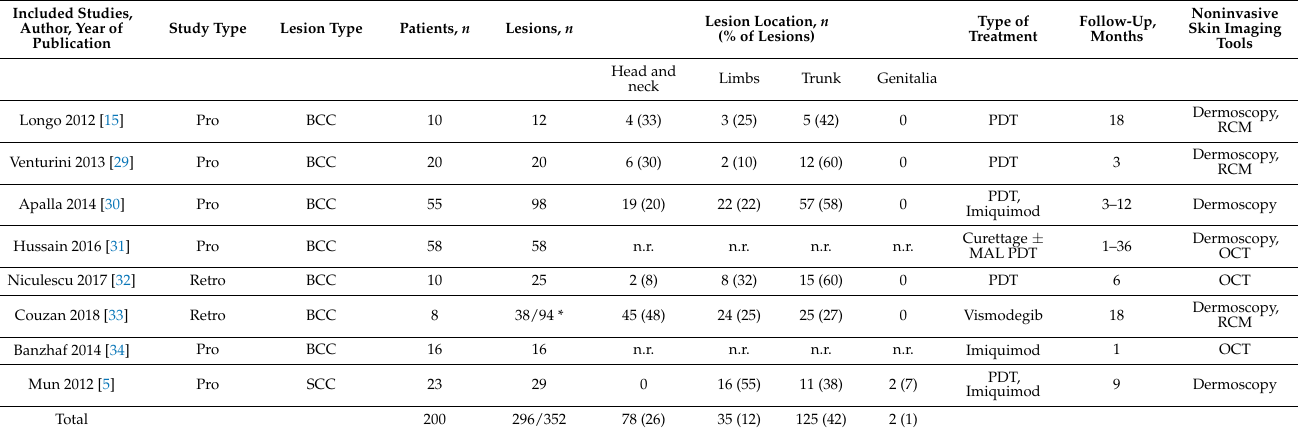
Table 1. Main characteristics of eligible studies.